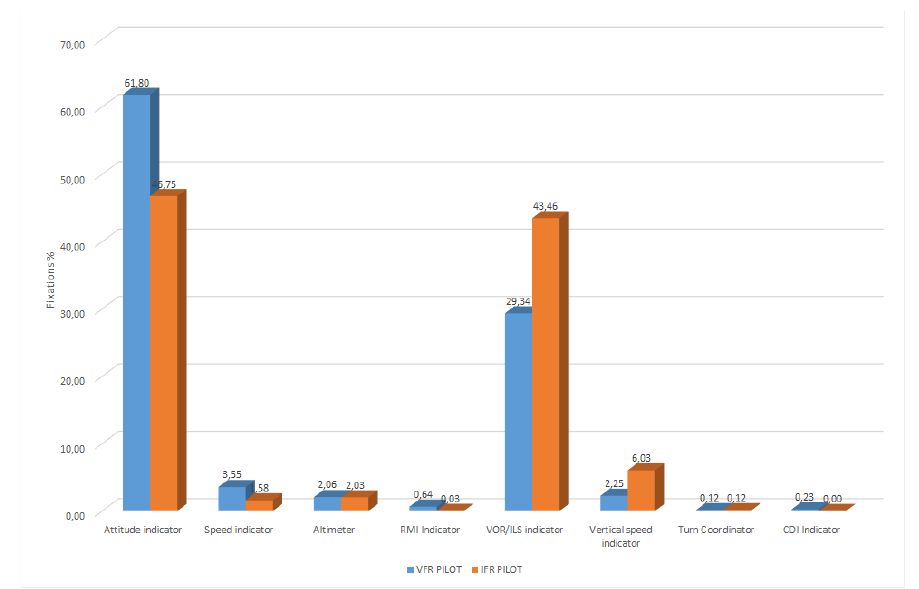
Figure 16. Average percentage time contribution for the two examined